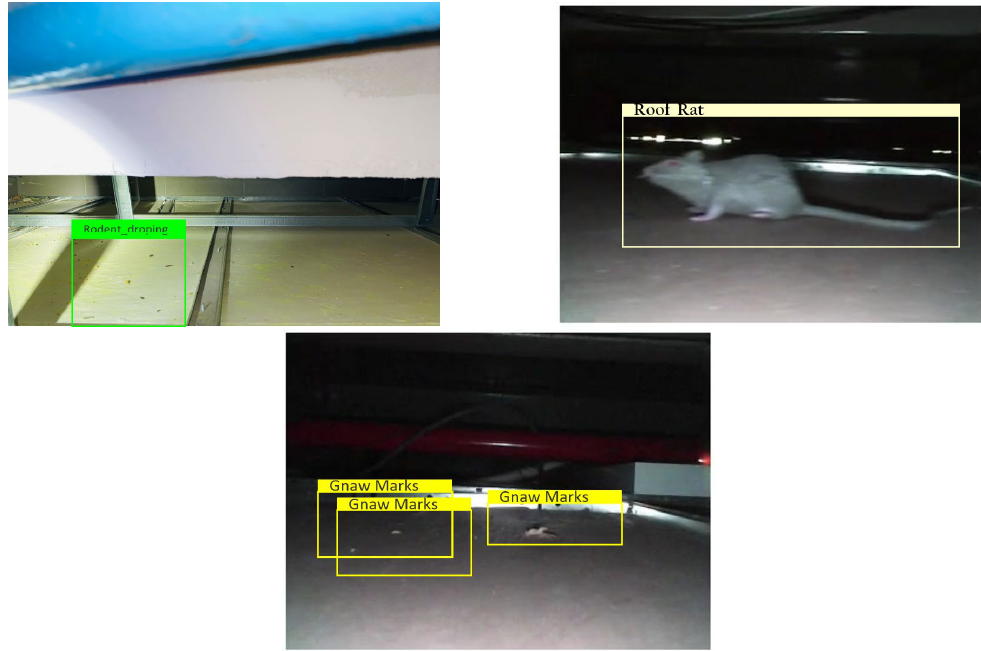
Figure 16. False ceiling testbed detection